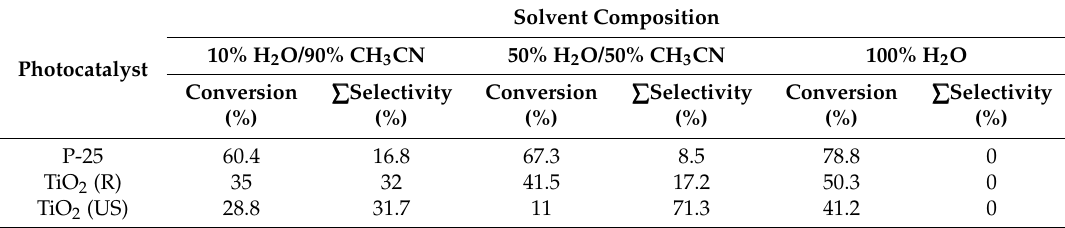
Table 1. Effects of solvent composition on glucose conversion and selectivity towards glucaric/gluconic acids and arabitol after 10 min of light irradiation from Colmenares et al. [24]. Solvent Photocatalyst